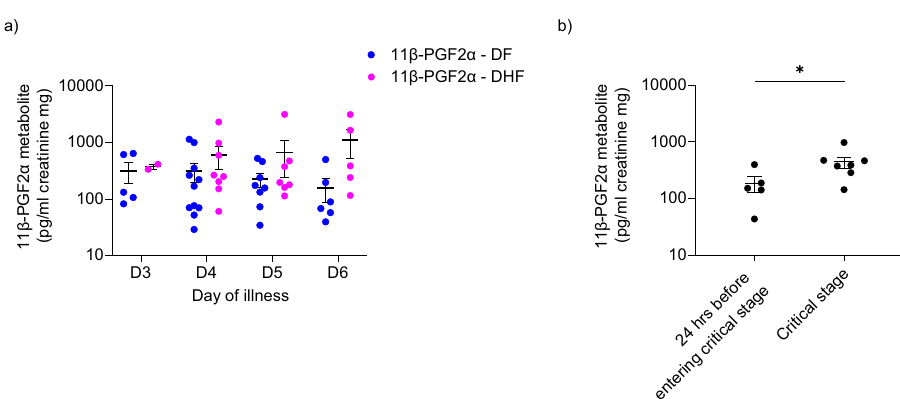
Fig. 6 Urinary PGD2 metabolite 11 β -PGF2 α levels in patients with acute dengue. Urinary a 11 β -PGF 2 α levels were measured by quantitative ELISA, in those with DF ( n = 12) and those who progressed to develop DHF ( n = 10) in serially collected samples on 3rd, 4th, 5th and 6th days of illness. Error bars represent standard error of mean (SEM) and mean. b 11 β -PGF 2 α levels were measured by quantitative ELISA, in those with DHF ( n = 7) 24 h before entering critical stage and during critical stage. Statistical signi fi cance was tested using T test. P * < 0.05. Error bar represent standard error of mean (SEM) and